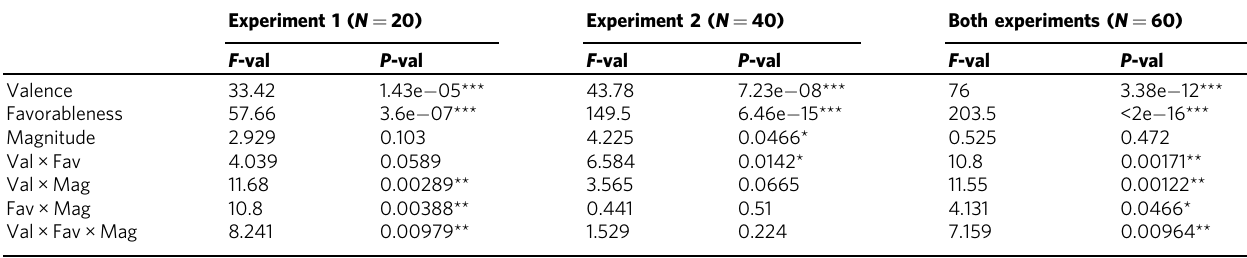
Table 2 Symbol choice rate of the transfer test as a function of task factors and option correctness in Experiments 1, 2 and both